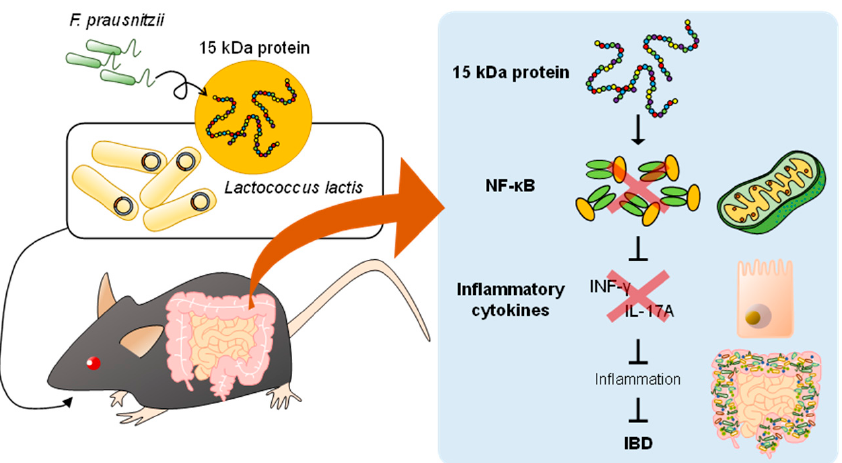
Figure 2. Improved intestinal environment alleviates IBD. Modulating gut microbiota, such as probiotics, fecal microbiota transplantation (FMT), and gut microbial metabolites, can alleviate IBD symptoms by suppressing gastrointestinal inflammation.